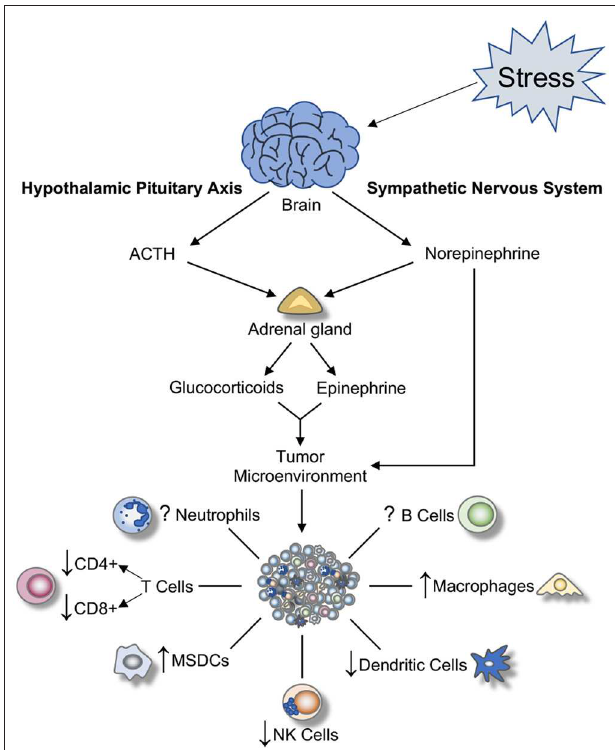
FIGURE 1 | Effect of SNS and HPA activation on tumor-associated immune cells. Once a stressor is perceived, a cascade of biochemical reactions is initiated. These result in the activation of the hypothalamic-pituitary-adrenal (HPA) axis, the sympathetic nervous system (SNS), and subsequent release of hormones and glucocorticoids from adrenal glands and nerve terminals in the periphery. These hormones alter the tumor microenvironment by promoting inflammation and modulating immune cell functions within the tumor. ACTH, adrenocorticotropic hormone; NK, natural killer; MSDCs, myeloid-derived suppressive